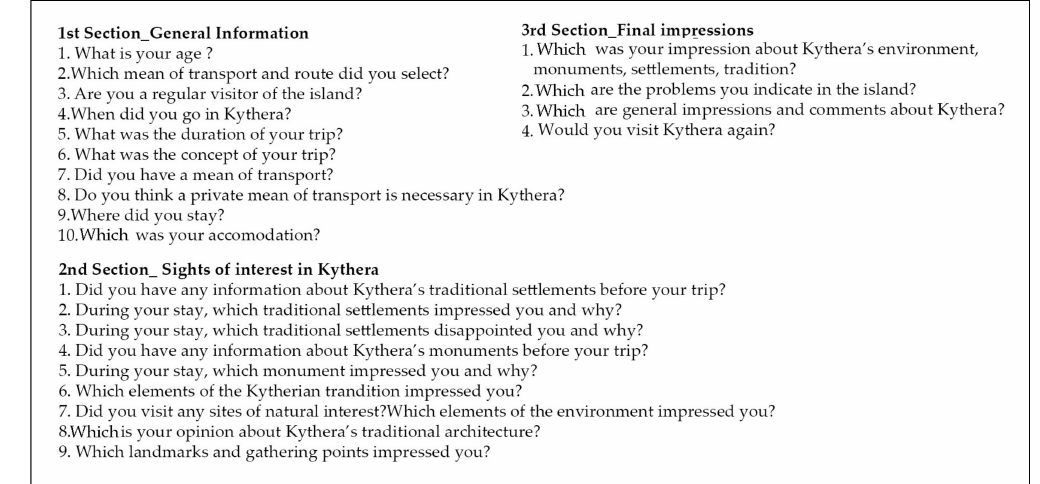
Figure 9. The questions addressed to the visitors of Kythera. In the age group 18–24 belong six respondents (17.6%), fourteen in group 25–34 (41.2%), three in group 35–44 (8.8%), one in group 45–54, seven in group 55–64 (20.6%) and three in the age group 65 and over (8.8%) (Figure 10a). Twenty of the respondents arrived from the port of Neapoli (Peloponnese) (58.8%), ten from the port of Piraeus (Attica) (29.4%), two from the port of Gythio (Peloponnese) and two arrived by plane from Athens (5.9%). Nineteen of them are regular visitors to the island (55.9%), while fifteen visited Kythera only once (44.1%) (Figure 10b). Thirty-two visited the island during summer (94.1%), while two during spring (5.9%). Twelve respondents stayed in Kythera for more than 15 days (35.3%), four stayed up to14 days (11.8%), seventeen up to 7 days (50%) and one up to 3 (2.9%) (Figure 11a). Fourteen of the respondents visited the island with friends (41.2%), twelve with their family (35.3%) and eight with their partner (25.3%). Twenty-nine had a private means of transportation (85.3%), while five did not (14.7%) when everyone considered the existence of a means of necessary transportation.